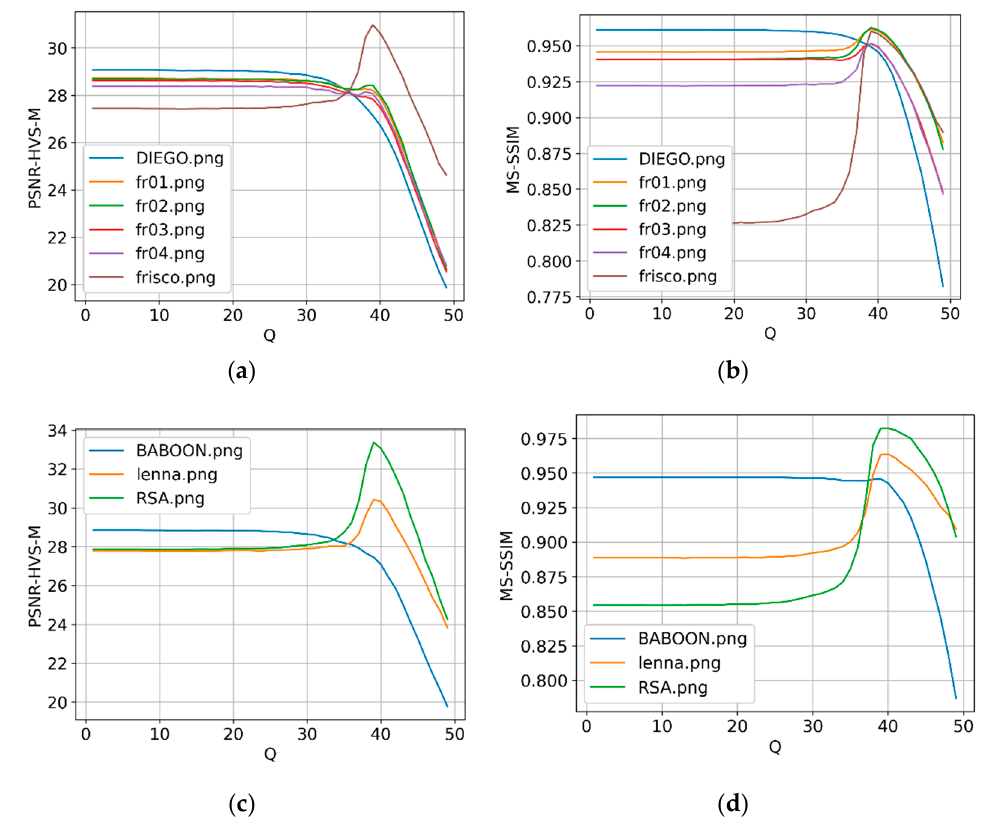
Figure 3. Dependences of the considered metrics (calculated between the true and compressed images on Q : PSNR − HVS − M tc ( Q ) ( a , c ) and MS − SSIM tc ( Q ) ( b , d ) for noise variance equal to 196.